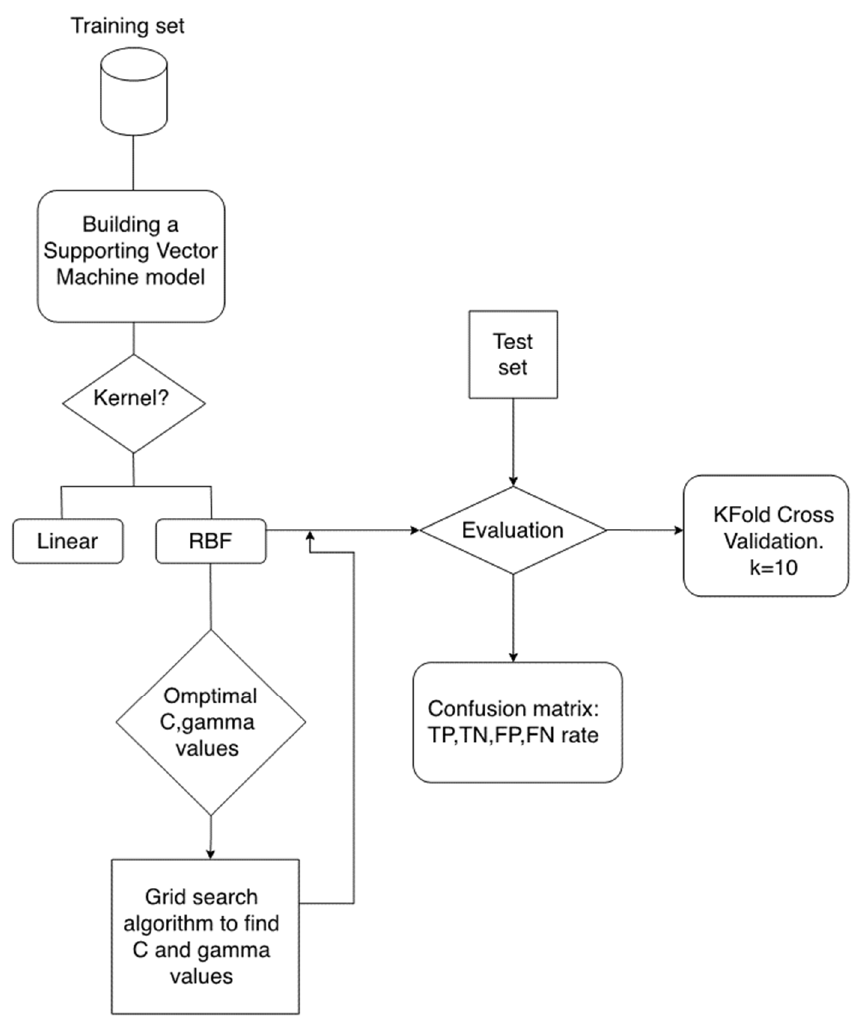
Figure 7. Flowchart of the building of the SVM model.